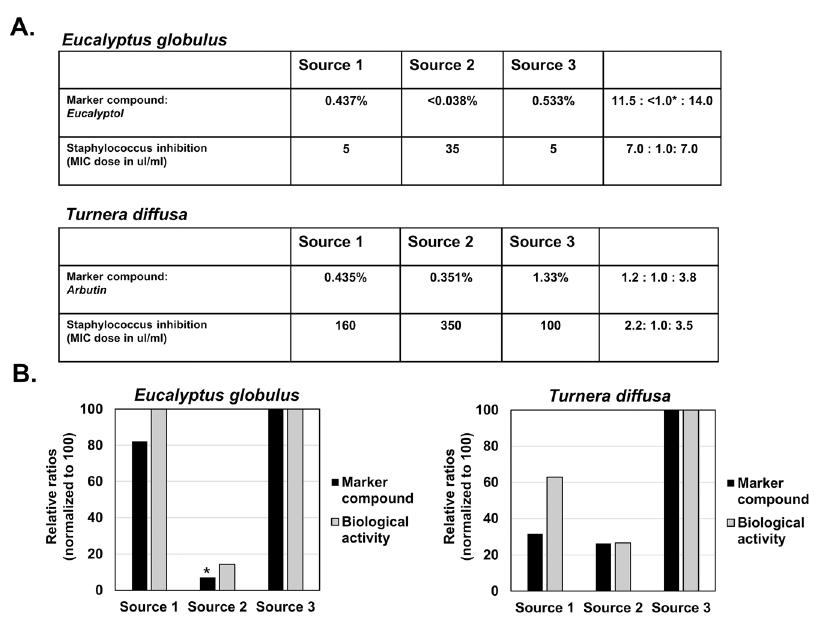
Fig 2. Marker compound level and bioactivity of antibacterial herbs. Part A) Marker compound level (percent of total weight) of eucalyptol (from E . globulus) and arbutin (from T . diffusa) and Staphylococcus aureus MIC values (microliters/ml) are shown from three commercial sources. Part B) Marker compound ratios and bioactivity ratios were normalized to 100 (max. level) and graphed.